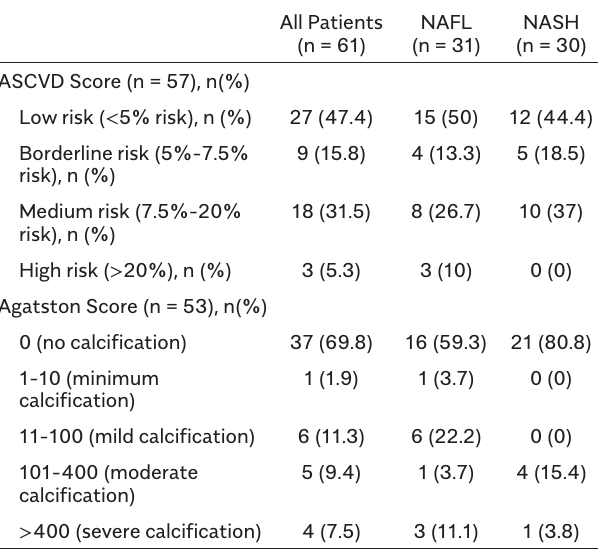
Table 3. Cardiovascular Risk Assessment of Patients